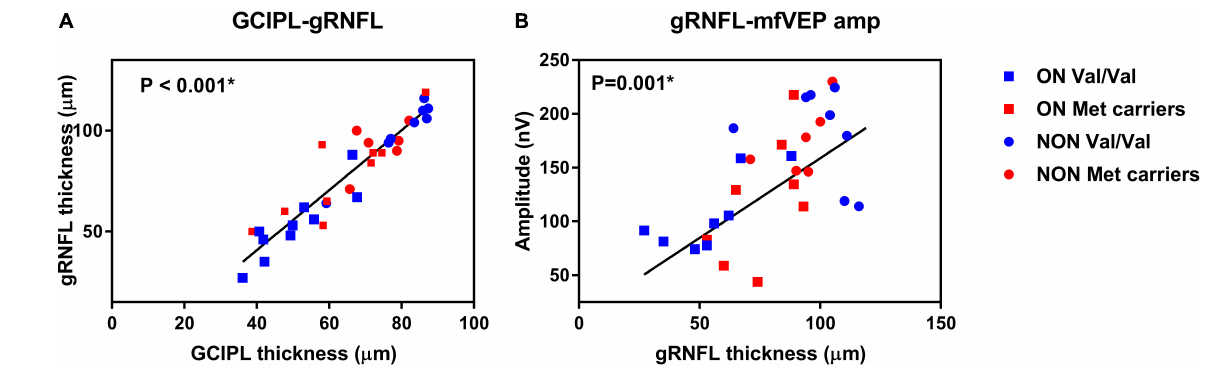
FIGURE 1 | Data visualization showing correlation analysis of (A) ganglion cell-inner plexiform layer (GCIPL) and global retinal nerve fiber layer (gRNFL) and (B) gRNFL and multifocal visual evoked potential (mfVEP) in neuromyelitis optica spectrum disorders